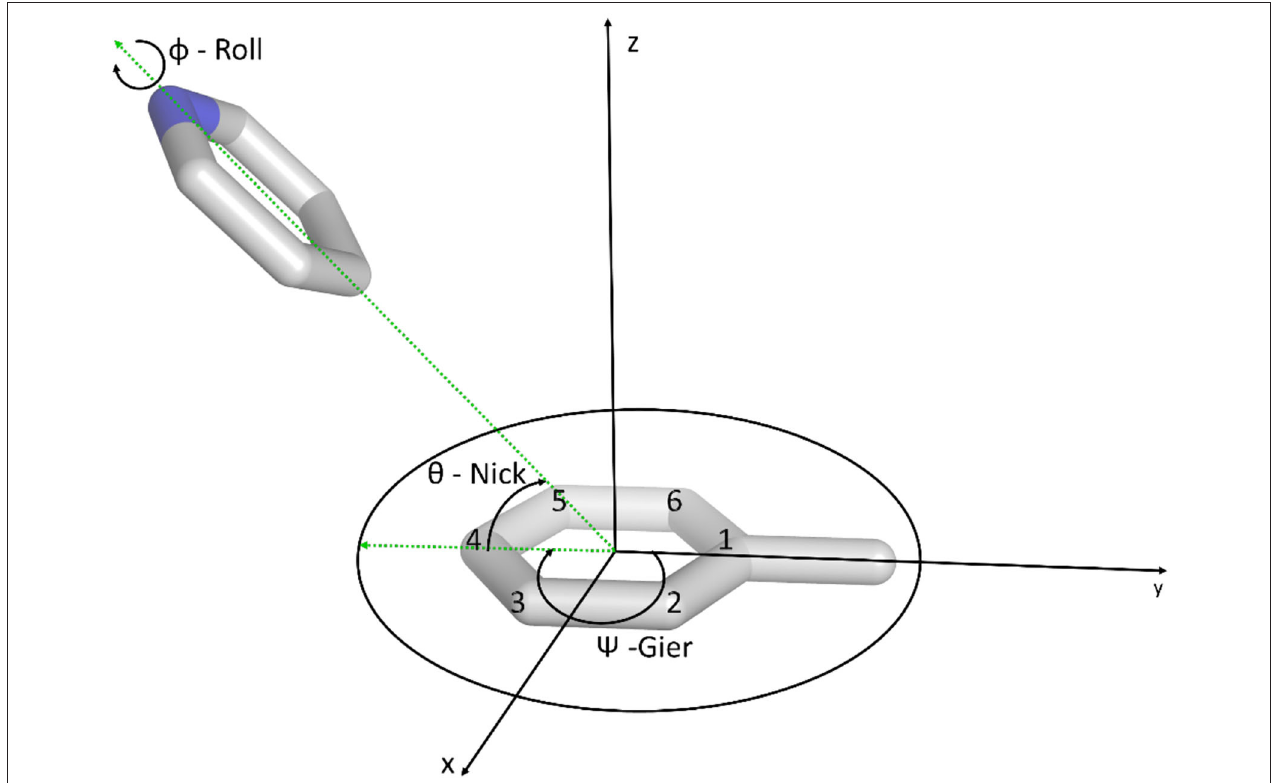
FIGURE 2 | Definition of the coordinate system and the Tait-Bryan angles used in the analysis process. The origin of the coordinate system is defined as the center of the benzene ring of